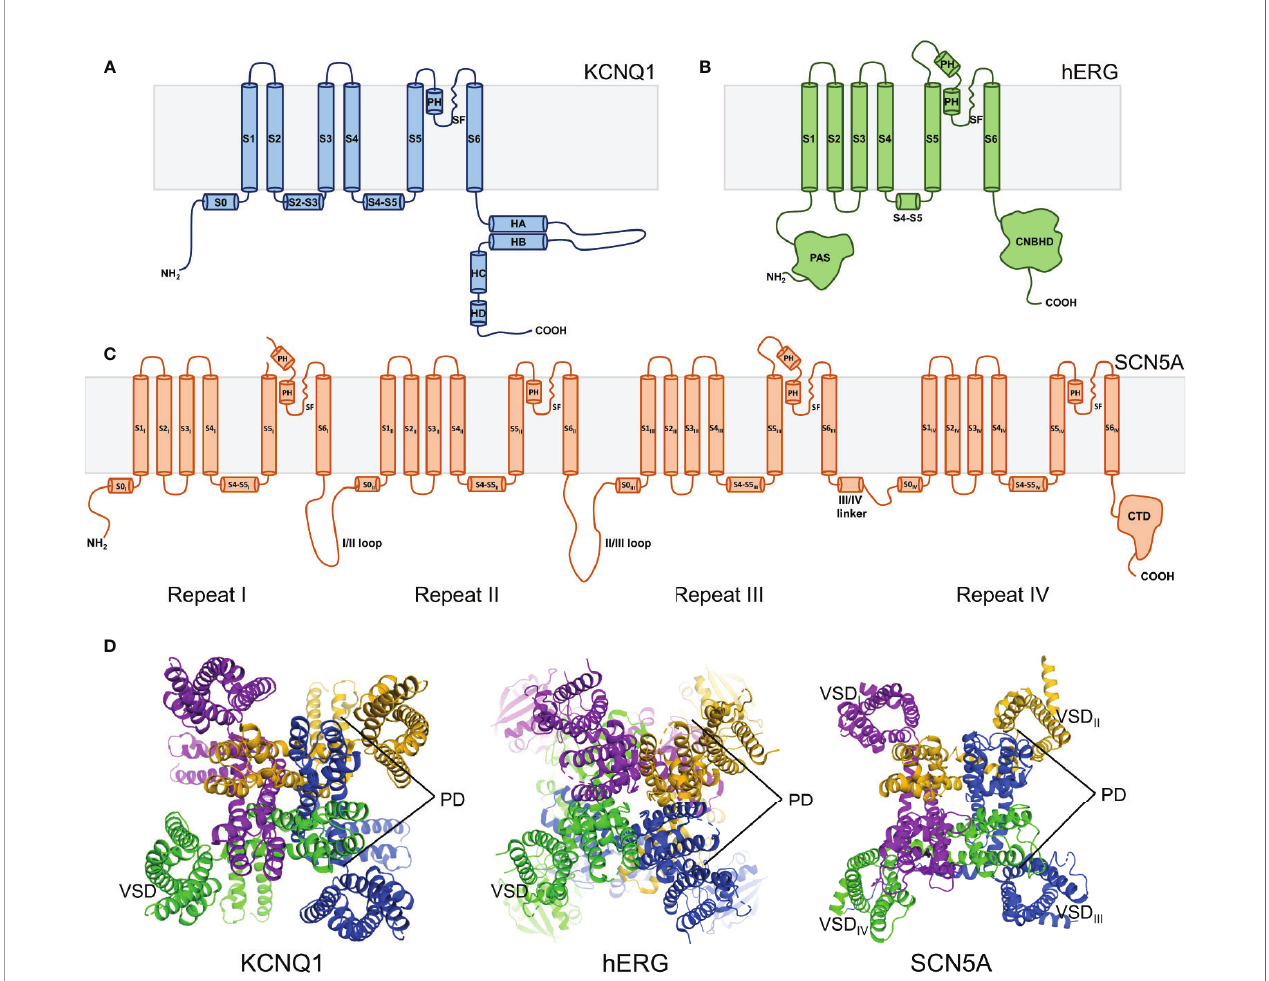
FIGURE 2 | Overall topology of KCNQ1, hERG, and SCN5A channels. (A) KCNQ1 topology. Transmembrane domain alpha helices are labeled S0 – S6. PH indicates the pore helix. SF denotes the selectivity fi lter. S2 – S3 indicates the S2 – S3 linker. S4 – S5 denotes the S4 – S5 linker. Cytosolic alpha helices are labeled HA-HD. (B) hERG topology. PAS denotes the Per-ARNT-Sim domain. CNBHD indicates the C-terminal cyclic nucleotide-binding homology domain. (C) SCN5A topology. CTD indicates the C-terminal domain. (D) Top views of the human KCNQ1 (PDB ID: 6UZZ) (Sun and Mackinnon, 2020), human hERG (PDB ID: 5VA1) (Wang and Mackinnon, 2017), and rat SCN5A (PDB ID: 6UZ3) (Jiang et al., 2020) channels, respectively. Outer voltage-sensing domains (VSD) and the central pore domain (PD) are